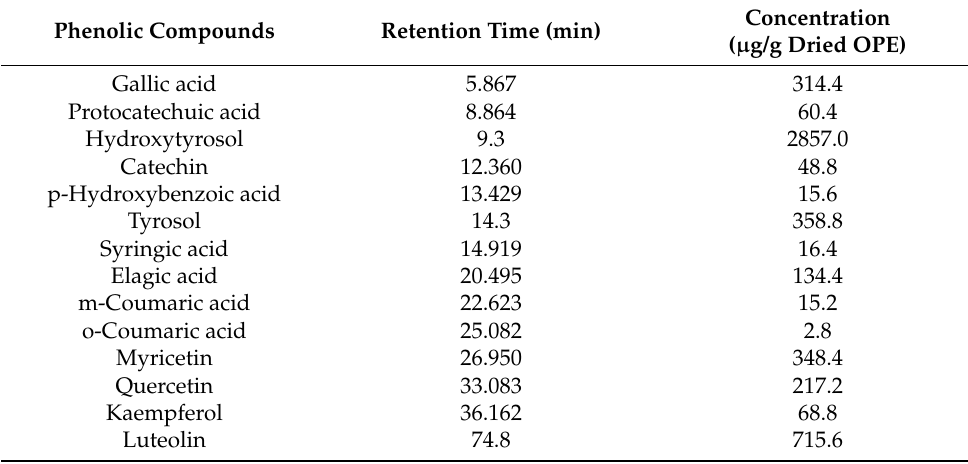
Table 2. Phenolic compounds of